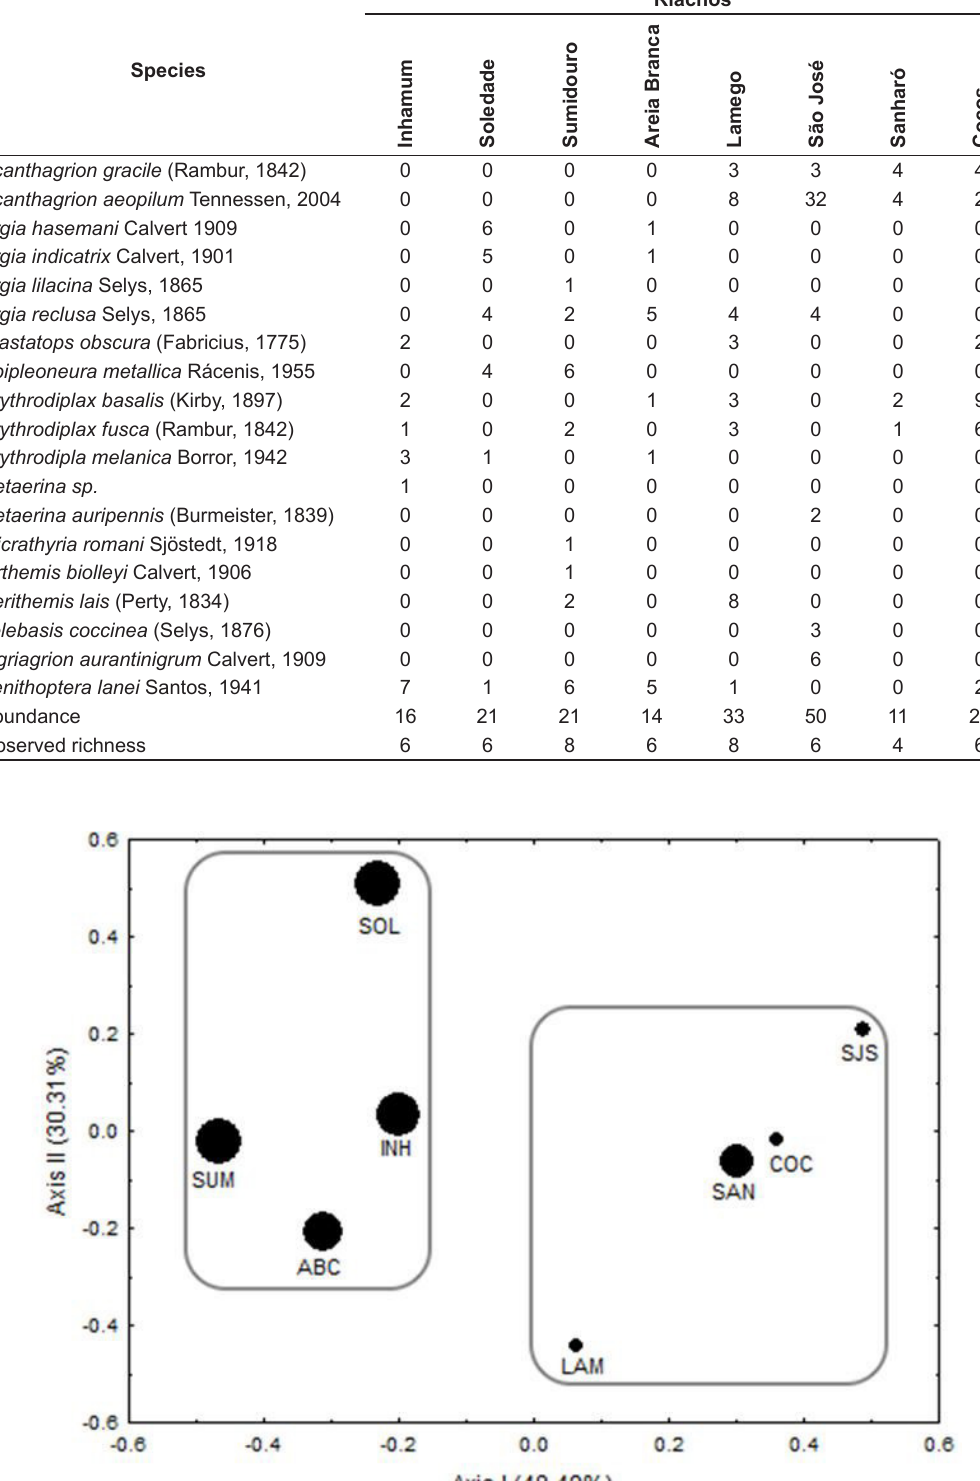
Table 2. Odonate species collected in the streams sampled in the municipality of Caxias, Maranhão (Brazil).